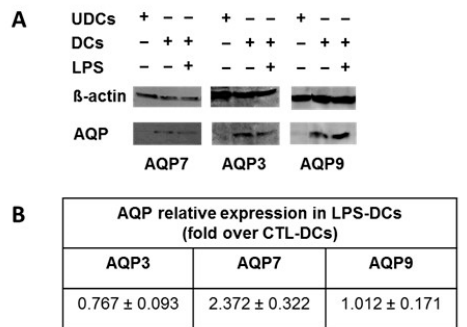
Figure 5. AQP3, AQP7 and AQP9 protein expression in UDCs, CTL-DCs and LPS-DCs. AQP3, AQP7 and AQP9 protein expression levels were determined in UDCs, untreated DCs (CTL-DCs) or LPS-treated DCs (1 µ g LPS/mL) by Western blotting analysis. ( A ) AQP7 (30 kDa), AQP3 (30 kDa), AQP9 (30 kDa) and β -actin (42 kDa) were detected using specific antibodies as described in Materials and Methods. Western blot was representative of 3 independent experiments; ( B ) The relative expression of each AQP was determined by densitometry analysis of the Western blots as described in Materials and Methods. Ratio between AQP band volume and β -actin band volume were calculated, the relative expression of each AQP in LPS-DCs is expressed in fold of the ratio calculated for CTL-DCs (set to 1) and is the mean ± standard error of the mean (S.E.M.) of 3 independents experiments. Statistical analysis